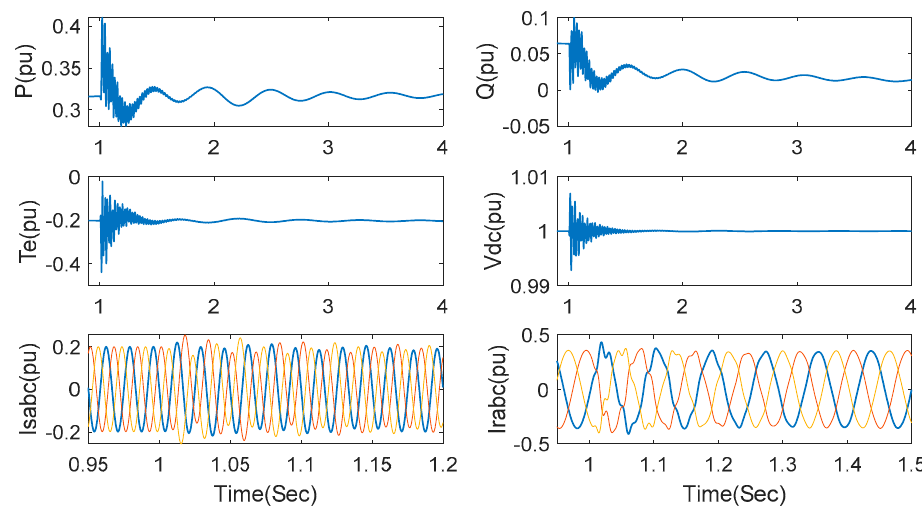
Figure 7. Responses under the proposed method with series compensation 35% and wind speed 7 m/s.